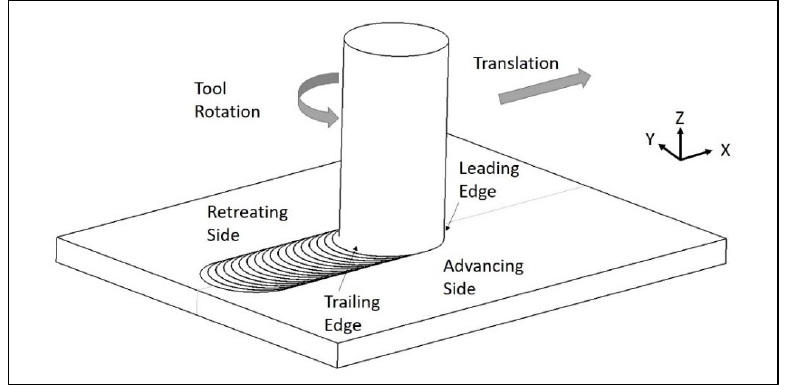
Figure 1. A schematic of the friction stir welding process with a generic coordinate system.